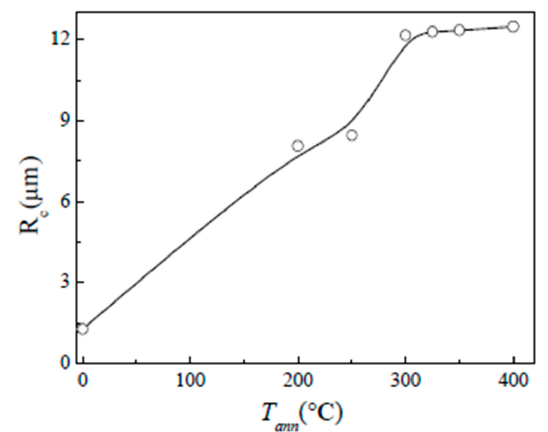
Figure 13. Dependence of radius of inner axially magnetized core, R c , on annealing temperature, T ann , in studied microwire. (Reproduced with permission from [49] Copyright © 2020 Elsevier B.V.)